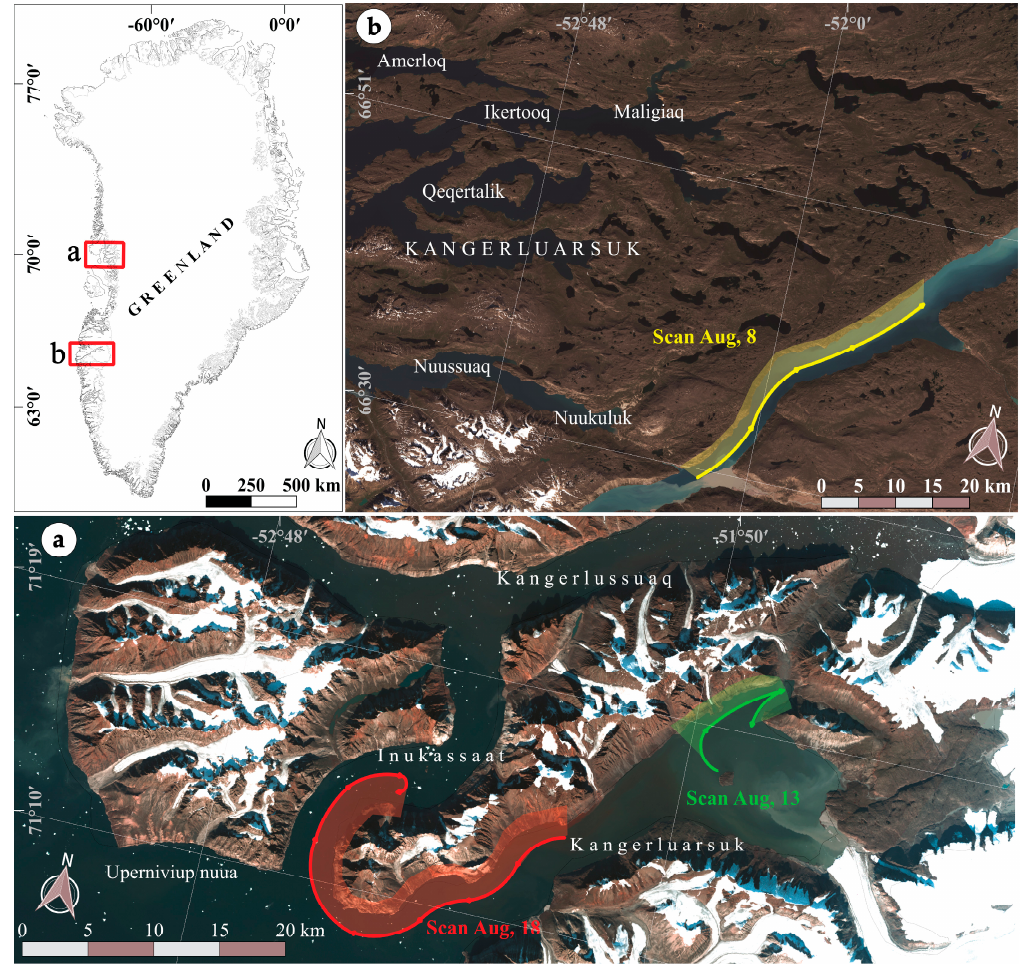
Figure 1. Landsat-8 OLI images of the study areas of: ( a ) Karrat; and ( b ) Søndre Strømfjord, which are marked by red boxes in the Greenland map. The hyperspectral sailing routes along the coastlines (on 13, 18 and 8 August 2016) are shown as green, red and yellow colors, respectively.